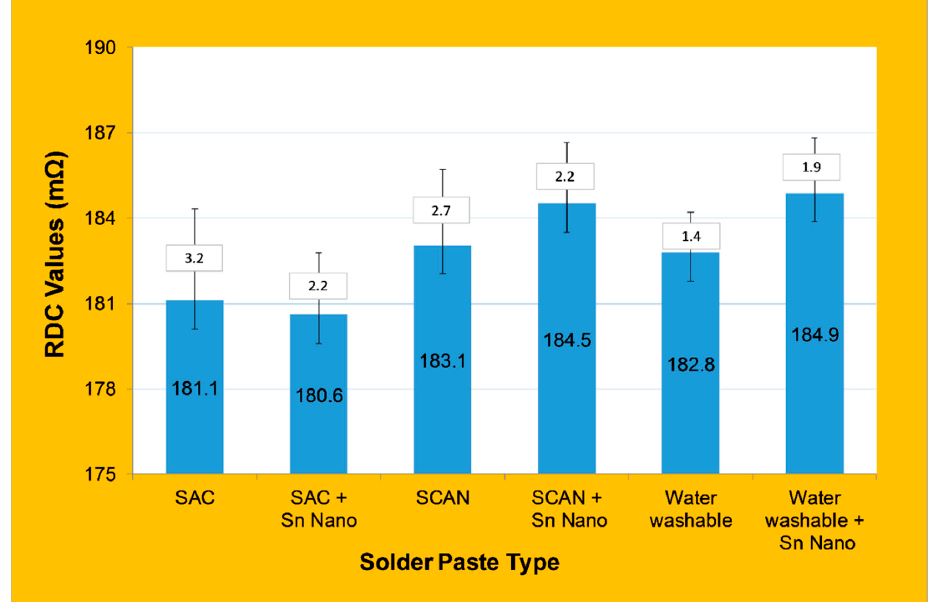
ff erent solder